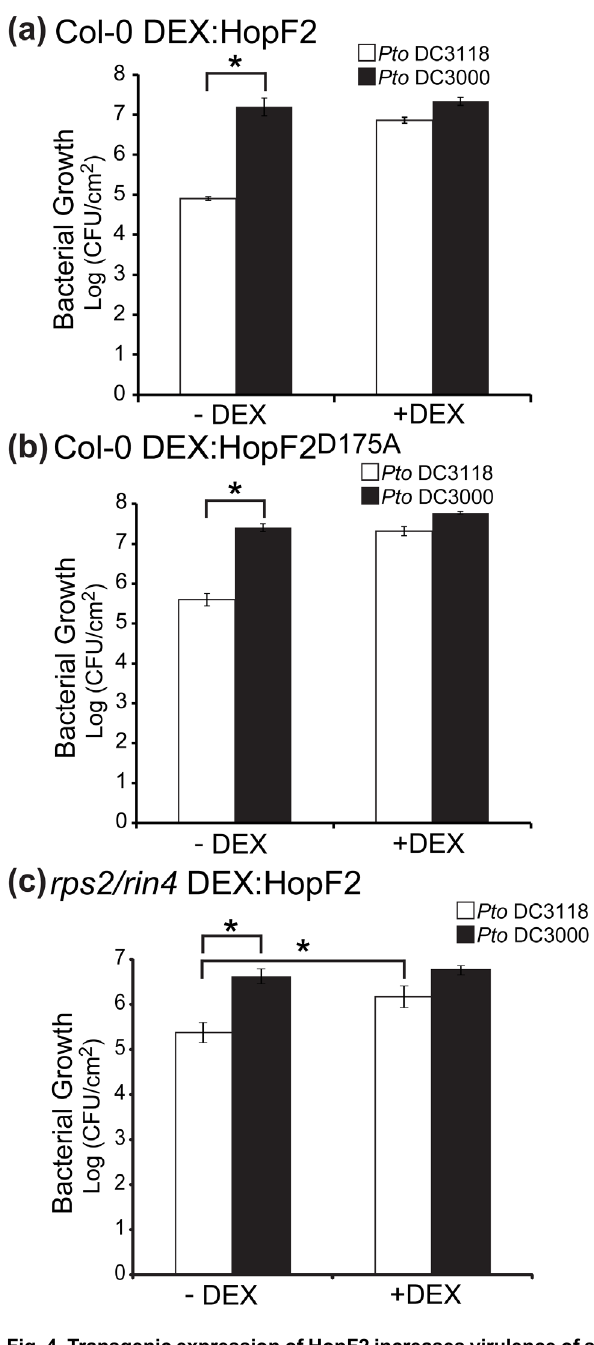
Fig. 4. Transgenic expression of HopF2 increases virulence of surface inoculated, coronatine deficient Pto DC3118. Four week old transgenic Arabidopsis expressing HopF2:HA under the control of a dexamethasone inducible promoter were sprayed with dexamethasone ( + DEX) or water (–DEX). Plants were dipped into 1 6 10 8 CFU suspensions of wild type Pto DC3000 or coronatine deficient Pto DC3118. (a) Wild- type HopF2:HA in Col-0 plants. (b) HopF2 D175A ::HA in Col-0 plants. (c) Wild-type HopF2:HA in rin4/rps2 plants. Bacterial growth curve analyses were performed 3 days post inoculation. Values are means ¡ S.E.M from n 5 12 plants. Asterisks denote significant differences between means (t-test, p , 0.05). Results are representative of 3 independent